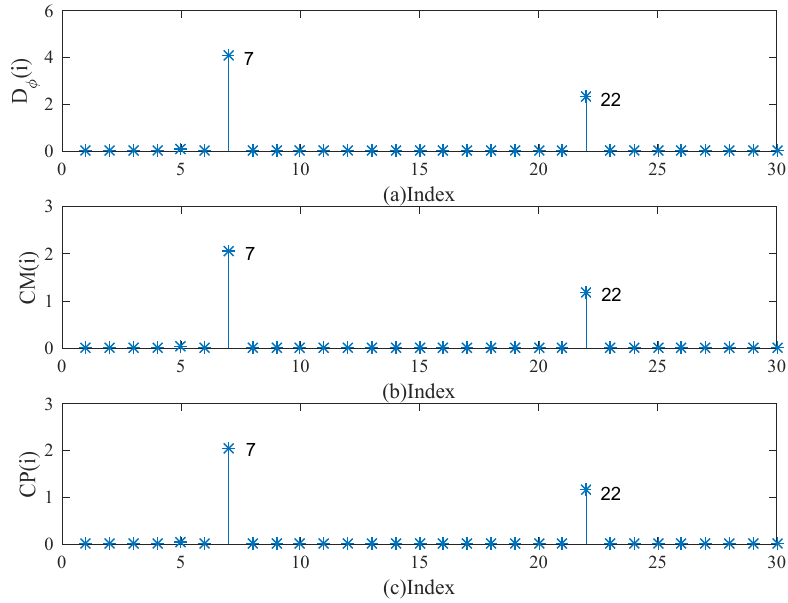
Figure 5. Diagnostic plots of response variables outliers in Simulation 3.